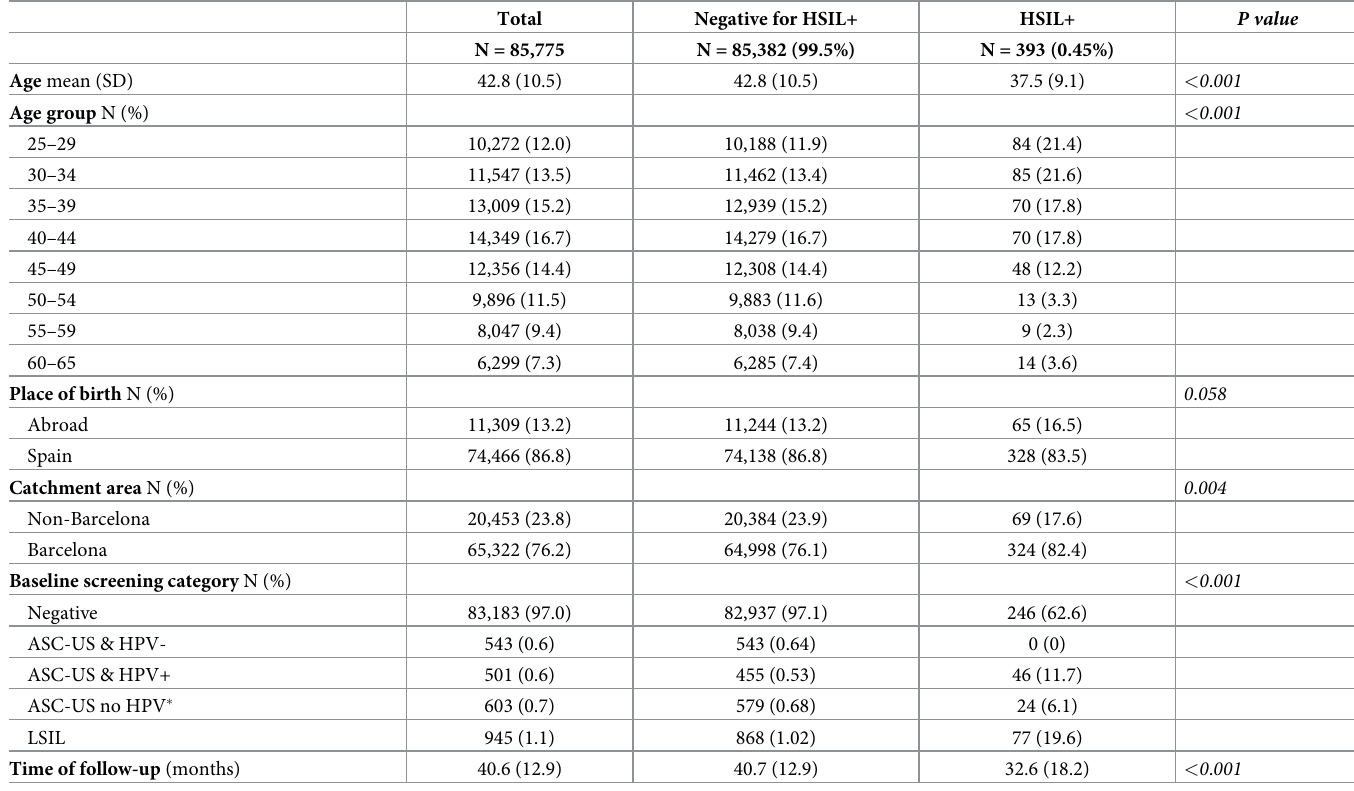
Table 1. Characteristics of the study population attending screening for the first time in 2010–11 by final category at the end of the follow-up period in 2015.